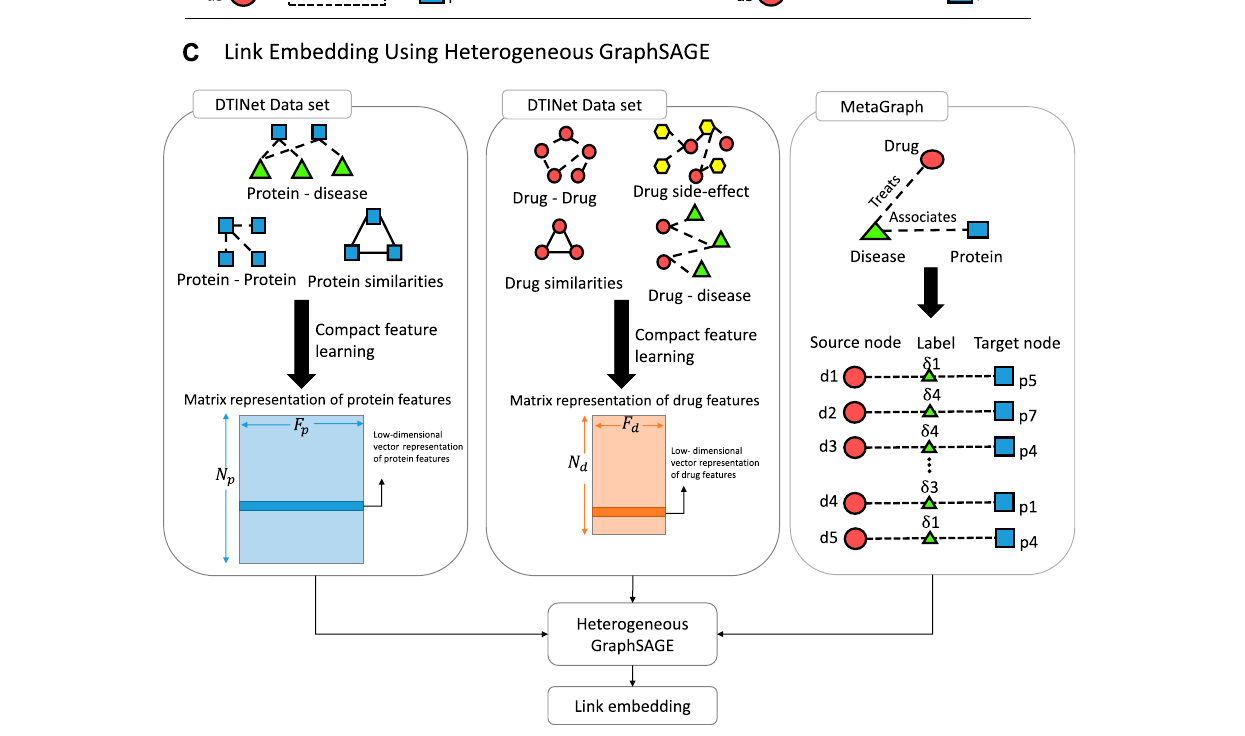
FIGURE 1 | Pipeline of DR-HGNN. (A) Creating Heterogeneous Drug-Disease-Protein Network: using the DTINet dataset, a meta-graph is created, which can be presentedasaHeterogeneousGraph(ontheright). (B) Multi-labelProblemTransformation:AproblemtransformationtechniqueisusedsincetheHeterogeneousGraph from stepA ismulti-labeled. (C) Link Embedding Using Heterogeneous GraphSAGE: With matrix representation of each protein and drug and the heterogeneous graph from step B, Heterogeneous GraphSAGE embeds links between nodes of this heterogeneous graph.